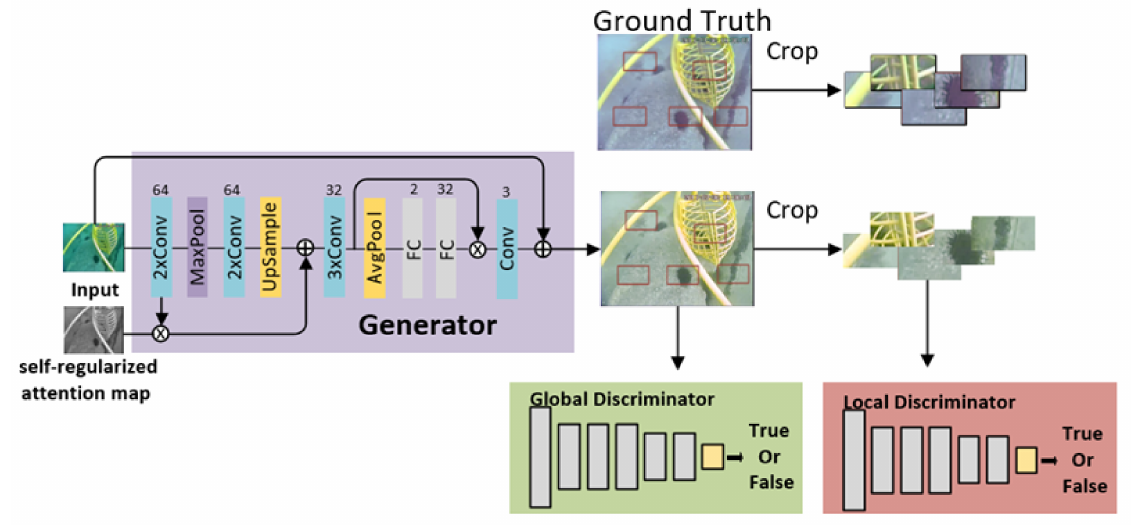
Figure 3. Overall structure of the color correction sub-module based on generative adversarial